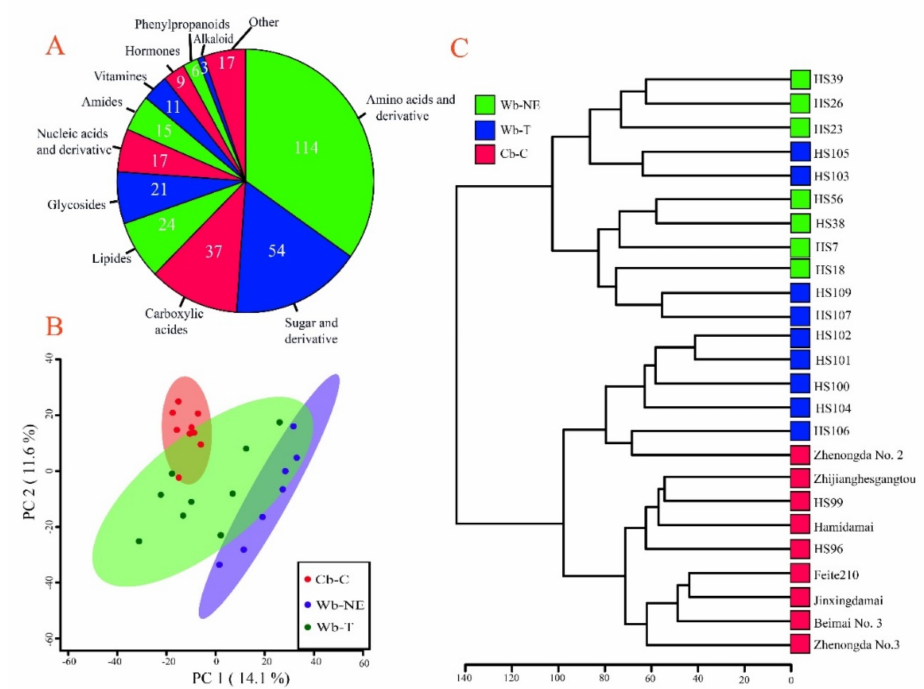
Figure 4. Metabolome divergence between Cb-C and its wild relatives. Wb-NE, wild barley from the Near East Fertile Crescent. Wb-T, wild barley from the Tibetan Plateau. Cb-C, cultivated barley from China. ( A ) Classification of metabolites with annotated structures. ( B ) PCA of the Cb-C, Wb-T, and Wb-NE accessions with all metabolites. PC1, the first principal component. PC2, the second principal component. ( C ) Hierarchical cluster of Cb-C, Wb-T, and Wb-NE accessions. The clustering tree was drawn based on Euclidean